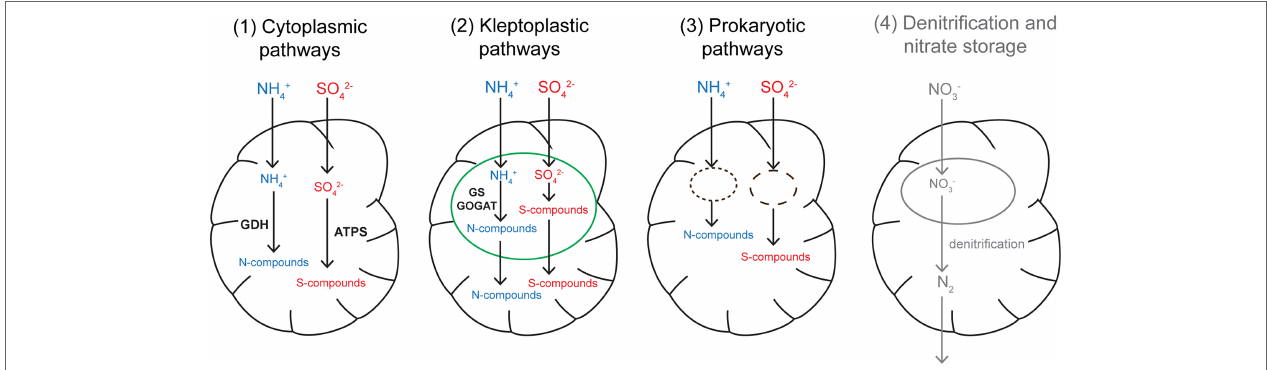
FIGURE 5 | Schematic diagram of the putative nitrogen and sulfate assimilation pathways in benthic foraminifera. Ammonium assimilation pathways are displayed in blue and sulfate assimilation pathways in red. In the cytoplasmic pathways, kleptoplastic and prokaryotic pathways, the assimilation of ammonium and sulfate result in N and S incorporation into the foraminiferal biomass. For nitrate uptake occurring in denitrifying foraminifer (shown in grey), N that enters the cell is reduced to gaseous nitrogen and exits the cell without being incorporated into the foraminiferal biomass. Green: kleptoplast; dashed black lines: prokaryotic